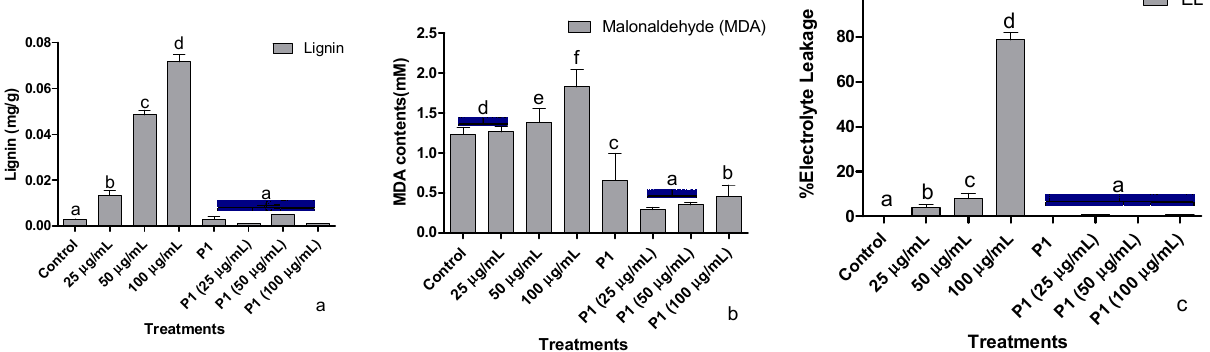
Figure 4. Effect of different concentrations of hexavalent chromium and P1 on ( a ) root lignification, ( b ) leaf malonaldehyde, and ( c ) electrolyte leakage of sunflower seedlings grown hydroponically (half-strength Hoagland’s solution) for 16 days in a plant growth chamber. Data are mean of 36 replicates with SE of the mean. Different labels on mean bars represent significance (Duncan; p < 0.05).